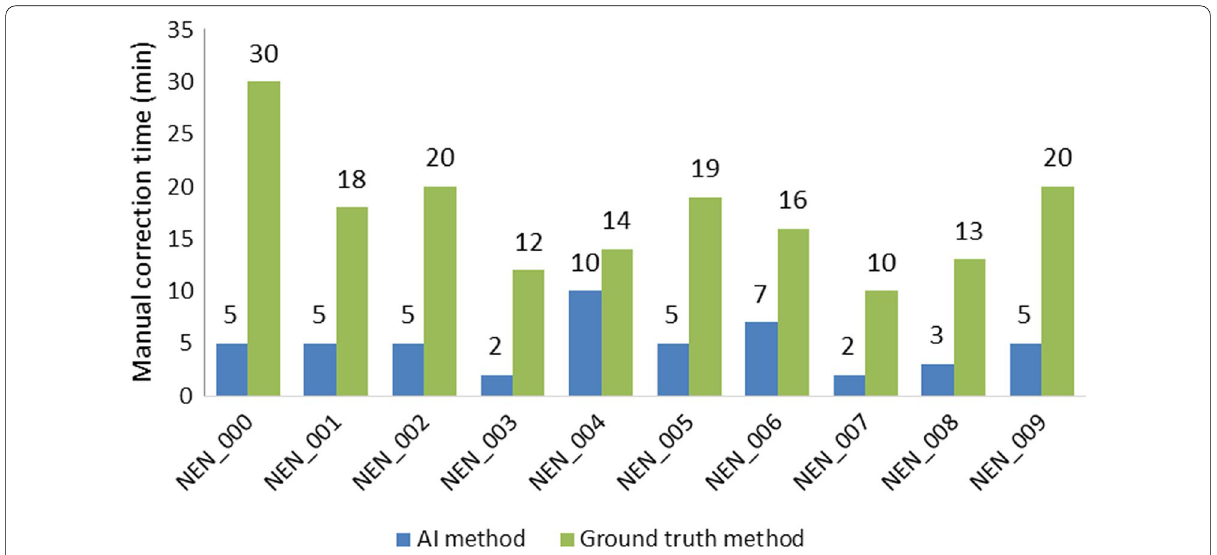
Fig. 4 Boxplot depicting time spent on manual correction to obtain the final total tumor